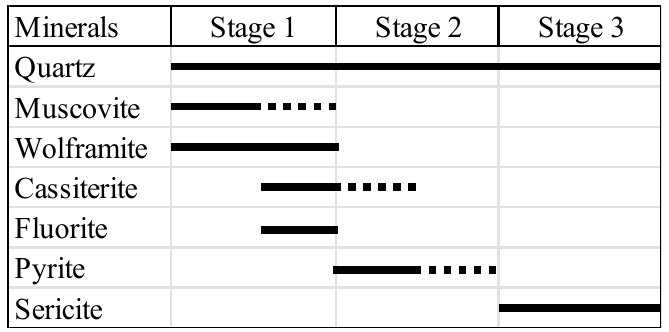
Figure 3. Sequence of mineral paragenesis of the Takatori deposit. Wolframite is the main ore mineral. The average tungsten content (as WO 3 ) is 0.5–3%. Wolframite and Li-bearing muscovite together with quartz are abundant in the outer part of the veins (early-stage precipitation), though quartz is ubiquitous in the Takatori veins. The Mn/Fe ratio of the Takatori wolframite is fairly variable